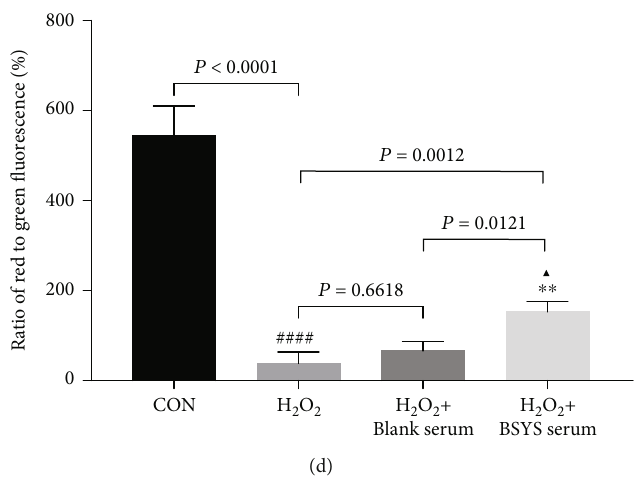
Figure 7: BSYS serum inhibits H2O2-induced ROS accumulation and MMP decrease in OLN-93 Cells. (a, b) The intracellular ROS level was assessed by DCFH-DA probe using fl uorescence microscope (scale bars: 25 μ m) and microplate reader. (c, d) The MMP was detected via fl uorescence microscope using JC-1 staining. Scale bar = 100 μ m . Data are presented as means ± SD , compared with the CON group, #### P < 0.0001, compared with the H group, ▲ P < 0 : 05 , ▲▲▲ P < 0 : 001